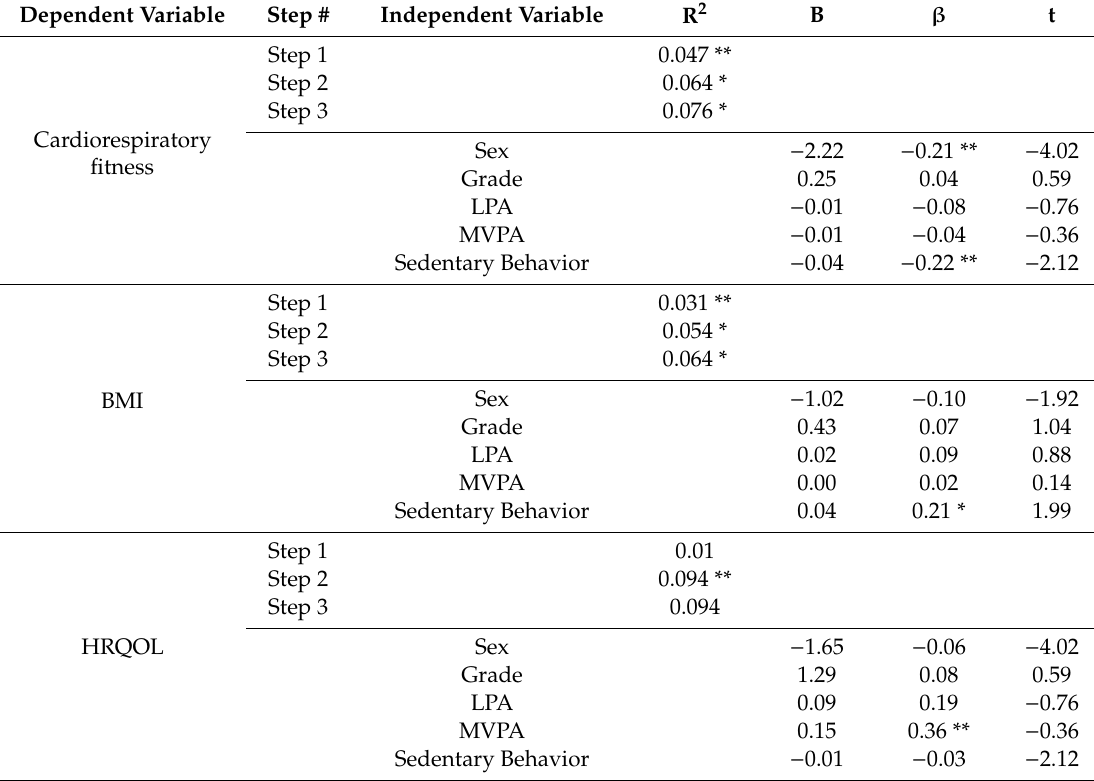
Table 3. Results of three hierarchical regressions for the health-related outcomes (N = 374). Dependent